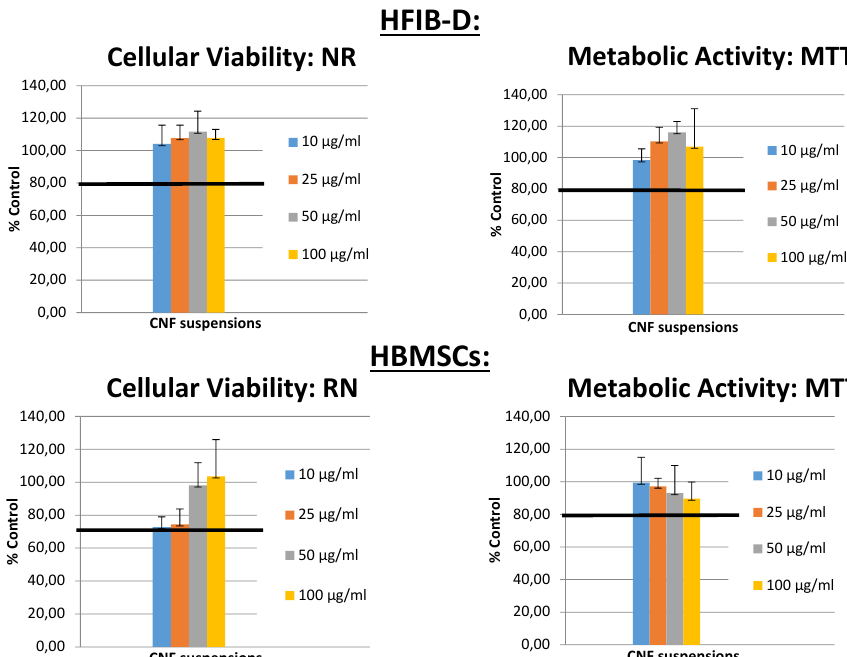
Figure 9. Cytotoxicity evaluation of cellulose nanofibers suspensions showing the cell viability (Neutral red (NR) assay) and cell metabolic activity (MTT assay) for human dermal fibroblasts (HFIB-D) and human bone marrow stromal cells (HBMSCs) for different CNF concentrations.